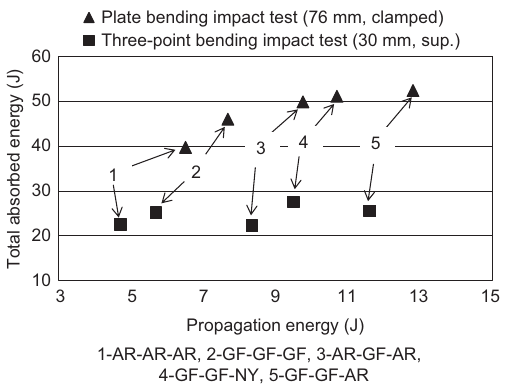
Figure 13 Relationship of total absorbed energy and propagation energy from the plate bending impact test and from the three-point bending impact